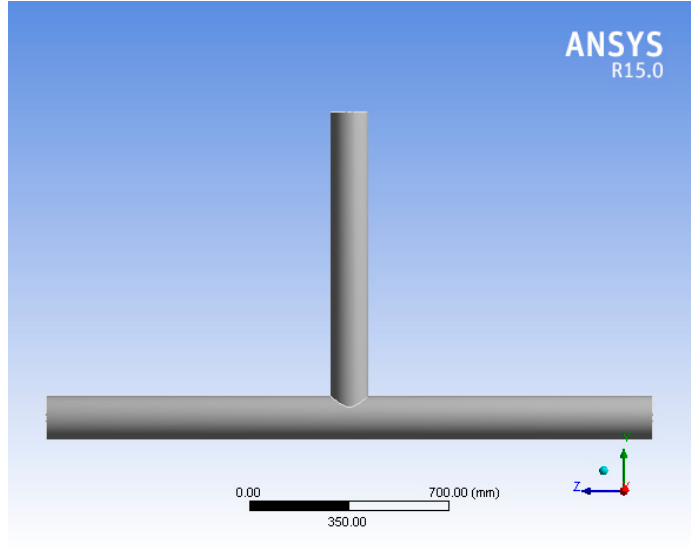
Figure 14. The 3D model diagram of the tee.